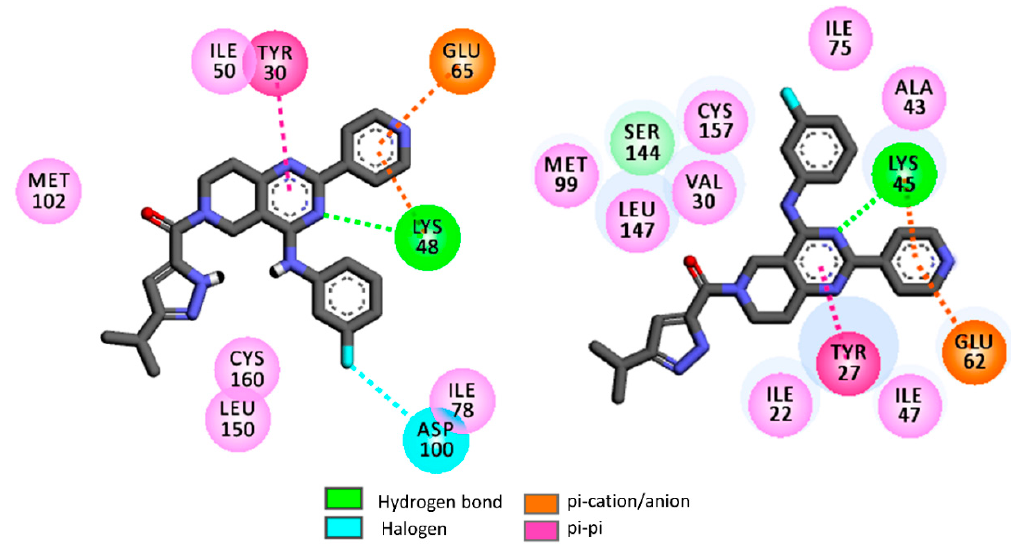
Figure 7. 2D rigid docking interaction diagrams of H1 with ERK-1 or 4QTB ( left ) and ERK-2 or 4QTA ( right ).